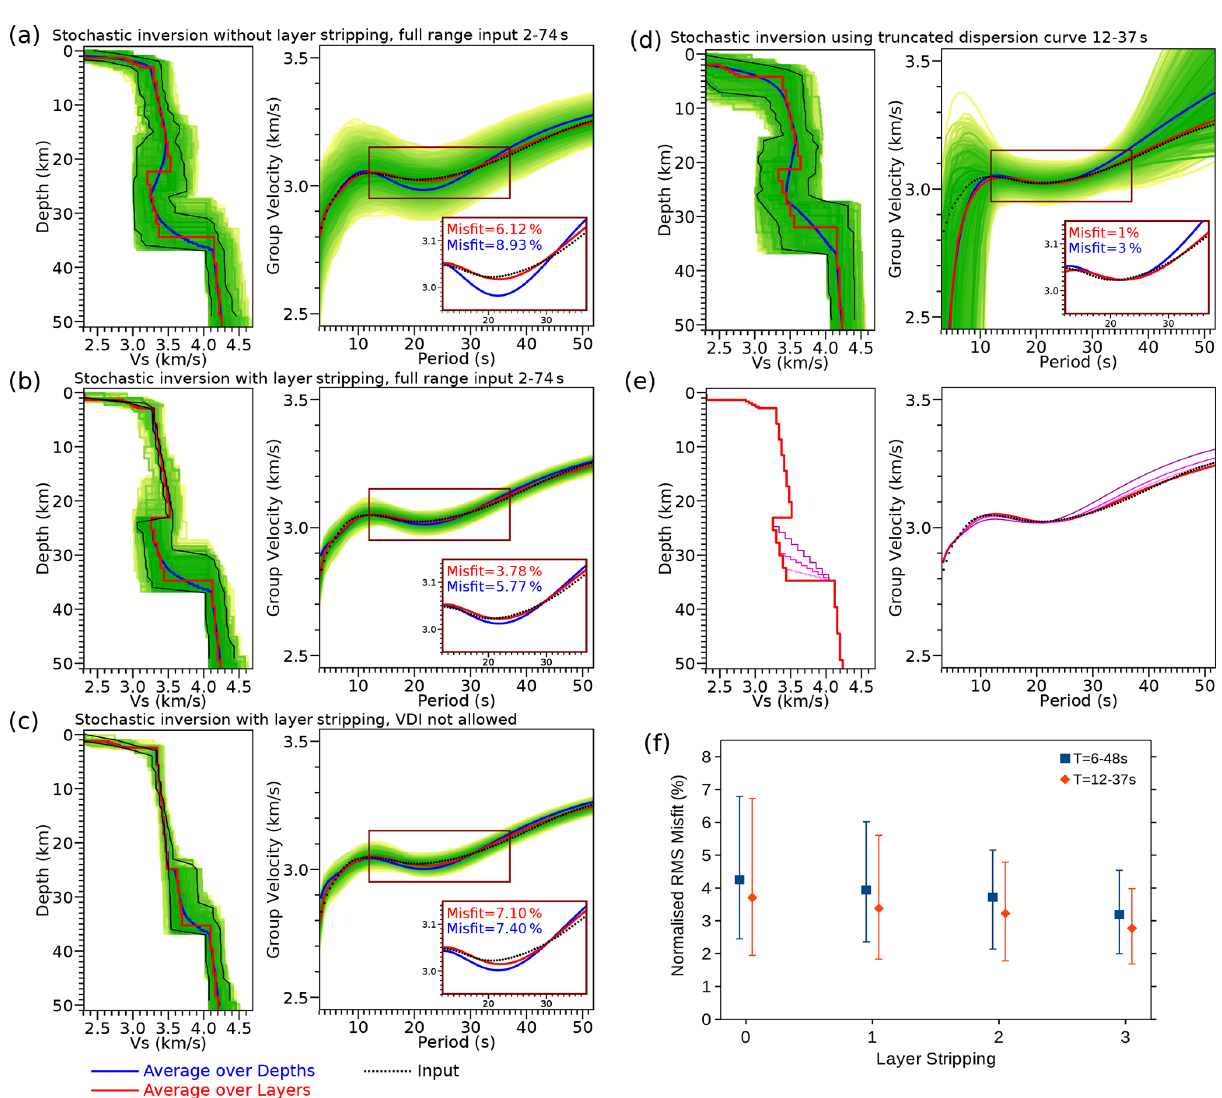
Figure 5. Examples of dispersion curves at 50.7 ◦ N, 14.4 ◦ E for velocity models computed with different parameters. In panels (a–d) , dispersions from models averaged over fixed depths are blue, and those from models averaged over layer indexes ( x i , z i ) are red. Individual parts of the figure show dispersion curves from models calculated without (a) or with (b, c) successive layer stripping from models where a velocity decrease was allowed (a, b) or was not allowed (c) during the inversions and from models resulting from inversions of the full-range dispersion curve (a) or the dispersion curve truncated at the 12–37s interval (d) . The misfit values are computed for parts of dispersion curves between 12 and 37s, and the colour represents the method of velocity model averaging. For more details, see the text. Tests of a gradational Moho against a sharp Moho (e) limit the thickness of the potential transitional layer to 2km. The yellow to green field marks 10% of the best-fitting models from 400000 computed models, with the thin black lines framing 1% of the best-fitting models. The first quartile, median, and the third quartile display misfits between the input dispersion curves and those computed for all of the final 1-D models (see panel b , red curve) after each step of layer stripping (f) in period ranges of 6–48 and 12–37s (blue and orange respectively). The misfit improves linearly with each run of layer